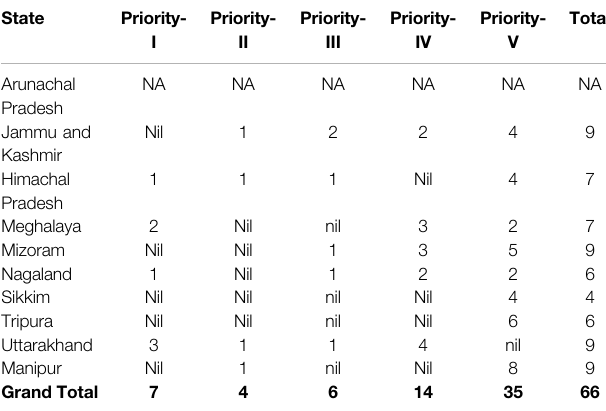
TABLE 4 | State-wize polluted river stretches characterized according to priority classes of IHR states (Data source: CPCB- river stretches